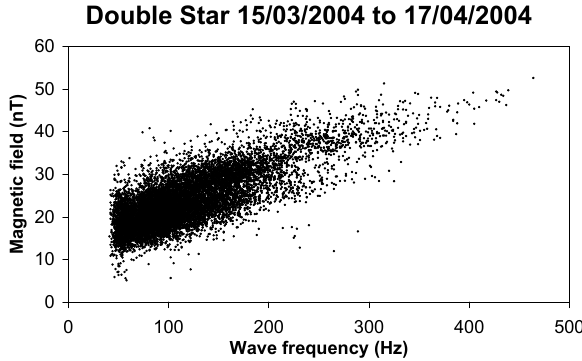
Fig. 3. Lion roar waveform measured by the X and Y antenna axes. The X trace has been offset by 3nT for clarity. The sensor does not measure the DC component of the field.